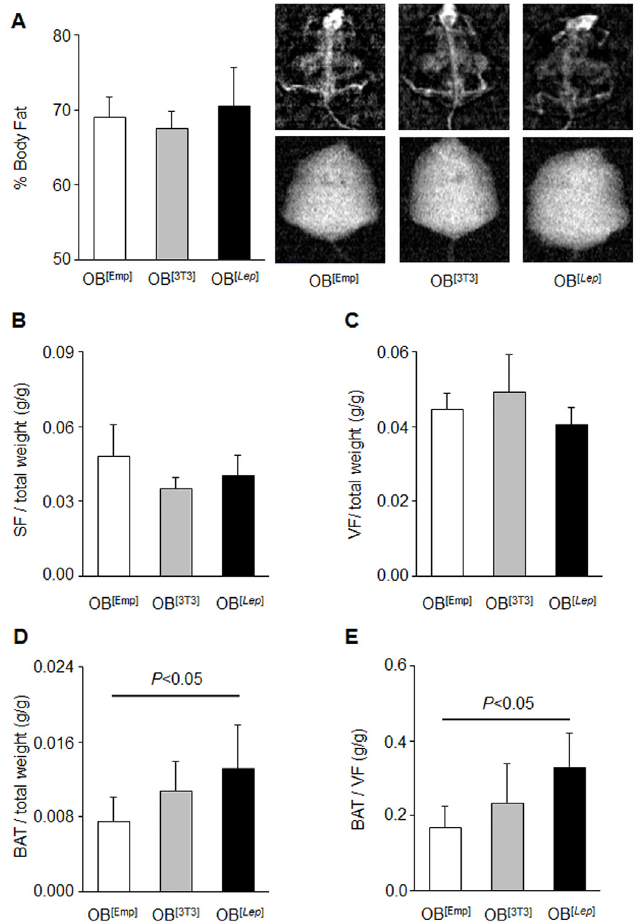
Fig 3. Treatment with leptin-producing encapsulated adipocytes increases BAT but not WAT weight. (A) Average percent body fat for OB [Emp] (white bar, n = 5), OB [3T3] (gray bar, n = 5), and OB [ Lep ] (black bar, n = 7) was measured using DEXA. Representative DEXA images are shown for each group. (B-D) Average normalized weight of subcutaneous fat (SF, B), visceral (VF, C), and brown (BAT, D) to body weight in same mouse groups. (E) The average ratio of BAT to VF in same mouse groups. All data are represented as mean ± SD. Significant differences are shown by black bar and determined by one-way ANOVA followed by Tukey ’ s